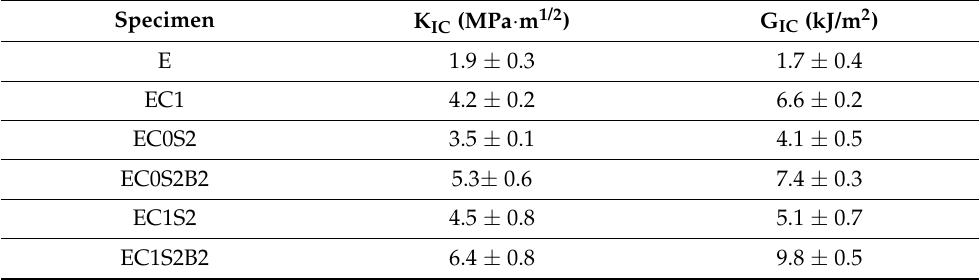
Table 4. Fracture toughness properties of epoxy, nano, and multiscale composite